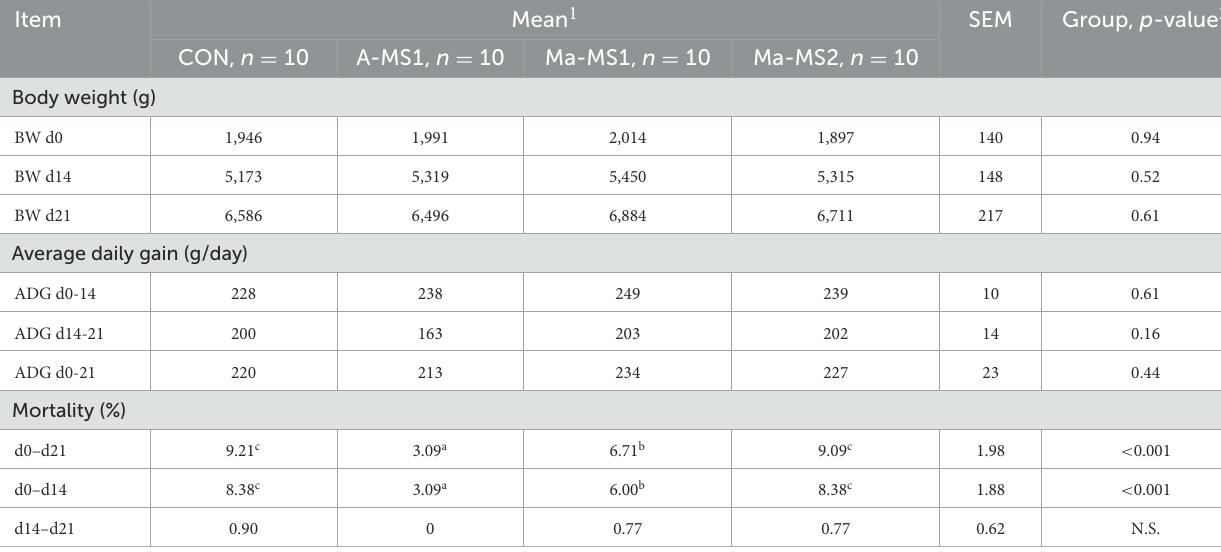
TABLE 5 Effect of milk supplementation on piglets’ litter performance during the suckling phase.